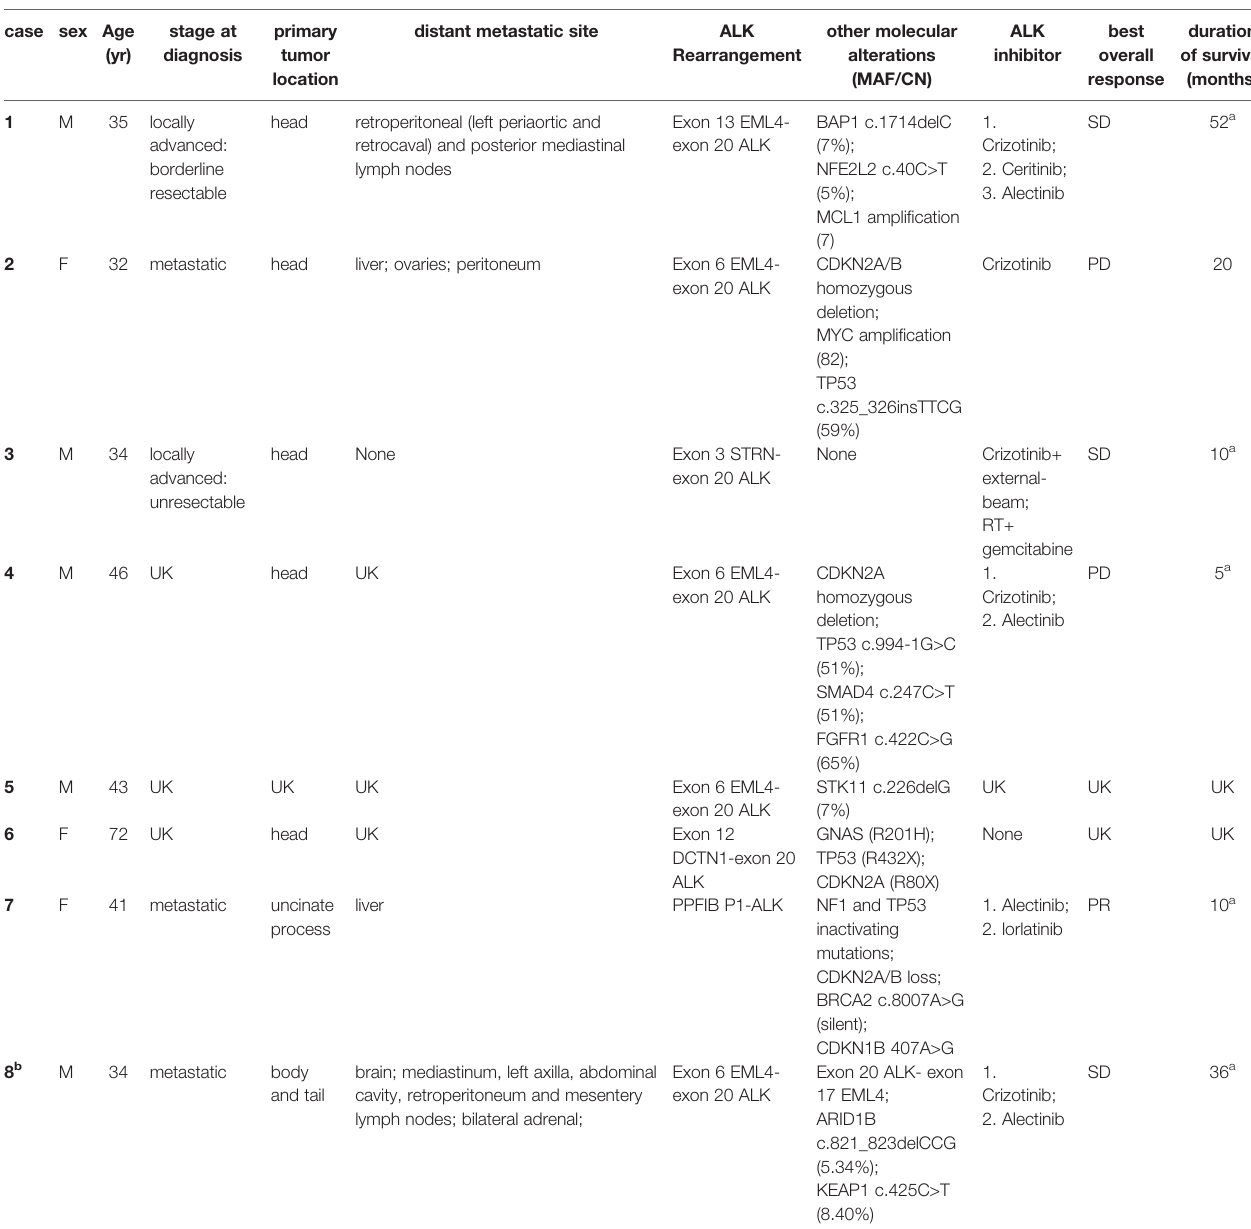
TABLE 1 | Characteristics of all eight cases with ALK-positive pancreatic cancer which reported to date. case sex Age